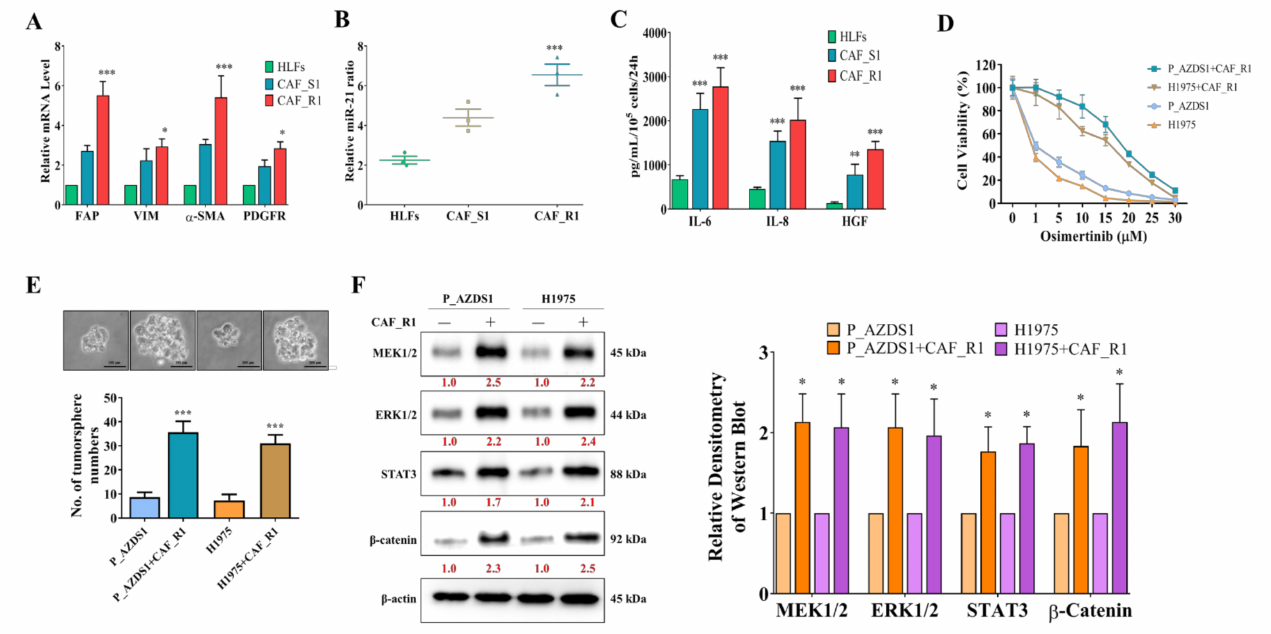
Figure 2. Osimertinib-resistant NSCLC cells transformed normal fibroblasts to cancer-associated fibroblasts and promoted drug resistance. ( A ) Real-time PCR analysis of CAFs transformed by co-culture with NSCLC cells. CAF markers were significantly higher in the CAFs when co-cultured with Osimertinib-resistant P_AZDR1 cells (CAF_R1 cells) as compared to Osimertinib-sensitive P_AZDS1 cells (CAF_S1 cells). ( B ) qPCR results showed that CAF_R1 cells contained a significantly higher level of oncomir, miR-21 than HLF and CAF_S1. ( C ) Comparative CAF cytokine profiles showed that CAF_R1 cells secreted a significantly higher IL-6, IL-8, and HGF than CAF_S1 and HLF. a, * p < 0.05; b, ** p < 0.01; c, *** p < 0.001 ( D ) Cell viability assay showed that CAF_R1 cells co-culture led to an increased Osimertinib resistance in both P_AZDS1 and H1975 NSCLC cells. ( E ) Co-culturing with CAF_R1 cells resulted in significantly increased tumor sphere formation ability in both P_AZDS1 and H1975 cells. ( F ) CAF_R1 cells co-cultured P_AZDS1 and H1975 cells showed a prominently increased expression of MEK, ERK, STAT3, and β -catenin as compared to their naïve counterparts and bar graph of multiple experiments. ** p < 0.01, *** p < 0.001. Scale bar: 100 µ